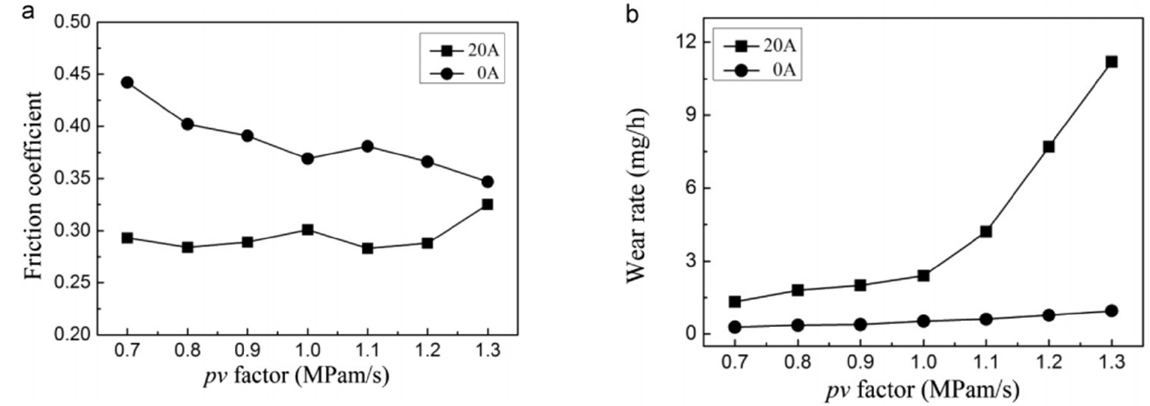
Figure 12. Variations in the ( a ) friction coefficient and ( b ) wear rate with the PV factor [88].